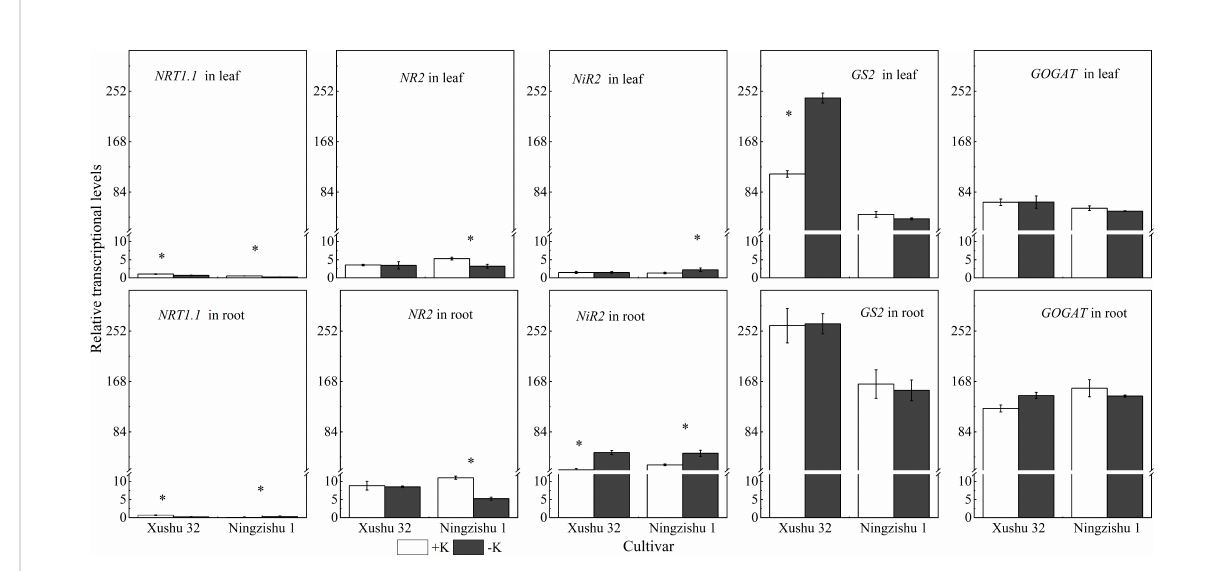
FIGURE 9 Effects of K de fi ciency on the transcription of N metabolism-related genes in leaves and roots of two sweet potato cultivars. Sweet potato seedlings were subjected to 15 days of K de fi ciency stress; total RNA was isolated from leaves and roots for real-time PCR analysis. The stages labeled with an asterisk (*) indicate signi fi cant differences ( p < 0.05) between − K and